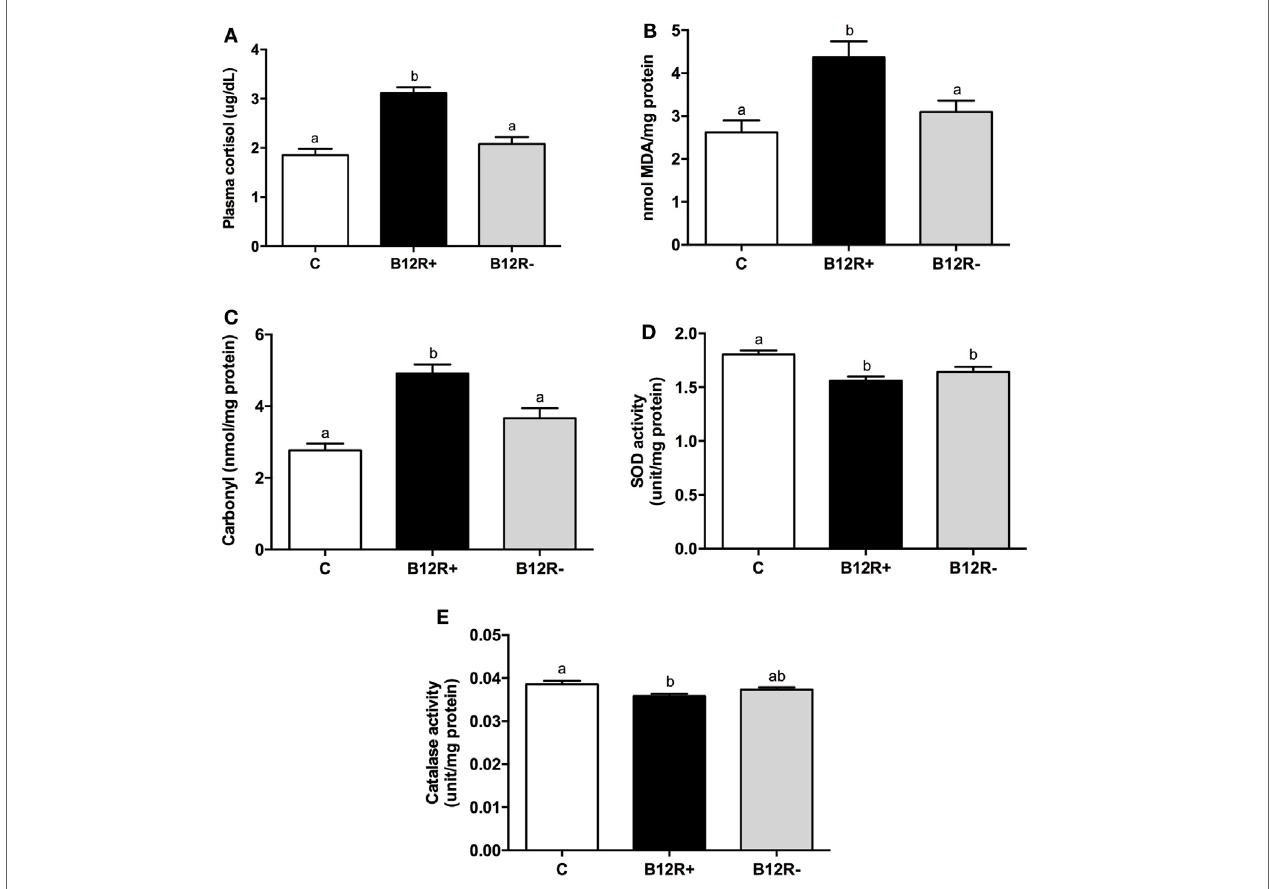
FigUre 3 | evaluation of markers of stress and antioxidant activity: (a) plasma cortisol level, (B) lipid peroxidation in liver, (c) protein carbonyl content in liver, (D) sOD activity in liver, and (e) catalase activity in liver. Bars with different superscripts (a/b) are significantly different from one another at p < 0.05 by one-way ANOVA/Bonferroni’s post hoc